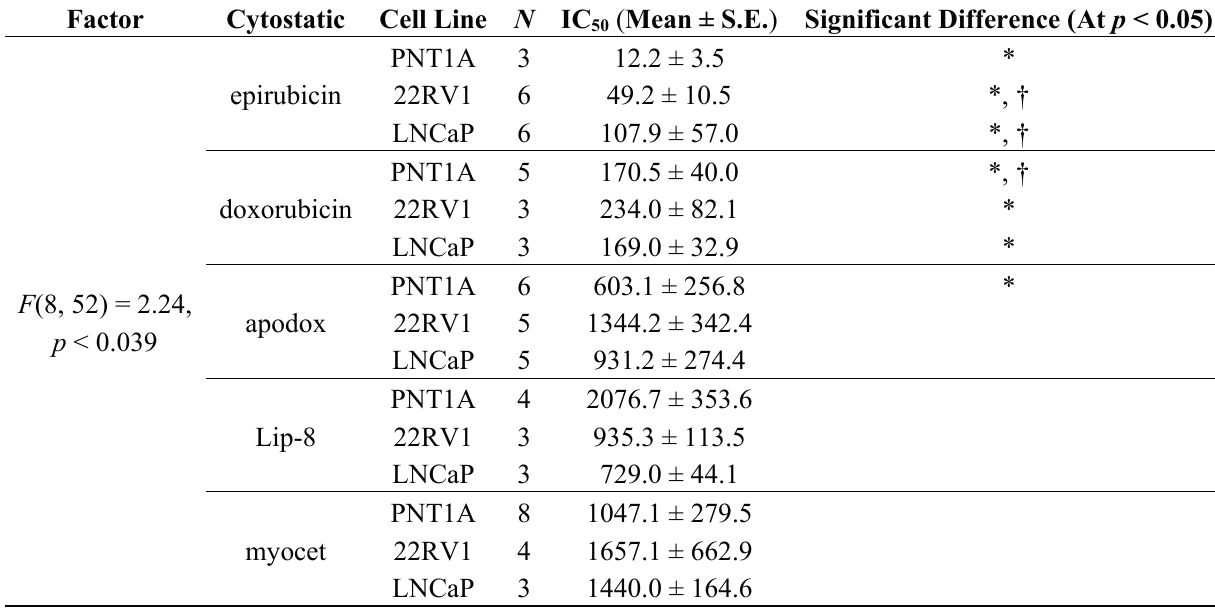
Table 2. Comparison of RTCA-based half-maximal concentrations (IC 50 ). S.E., standard error. Differences were considered significant, when p < 0.05; * Significantly different from lip-8-dox PNT1A (ANOVA followed by Bonferroni post hoc testing); † Significantly different from myocet 22Rv1 (ANOVA followed by Bonferroni post hoc testing).